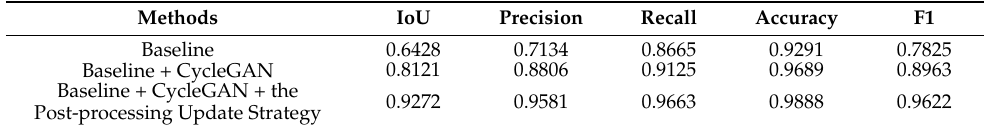
Table 9. Ablation experiments of the proposed update algorithm on the Beijing Huairou district land survey dataset.